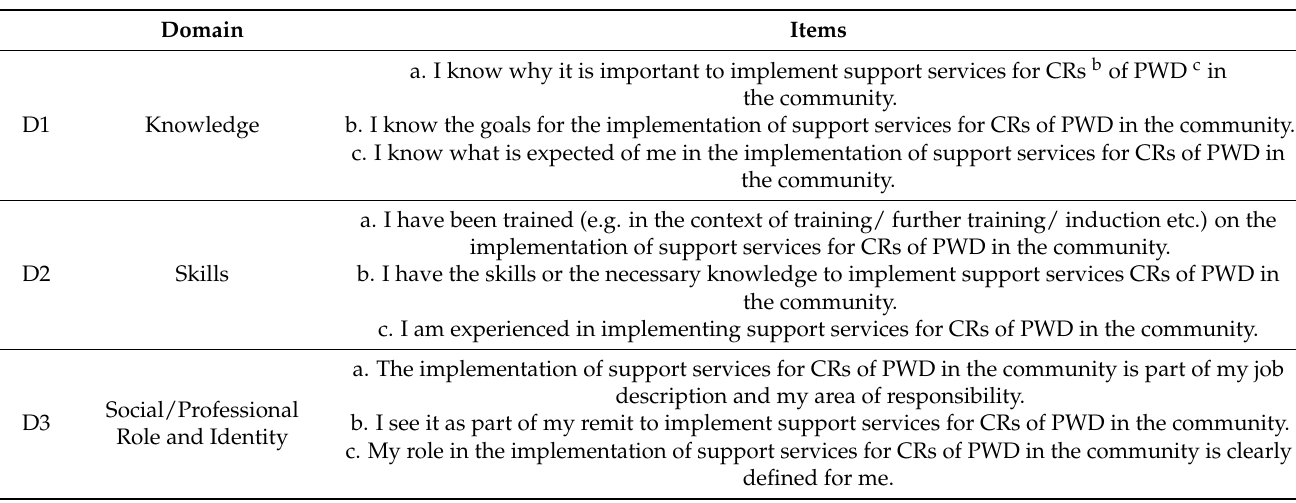
Table A1. Community Implementation Behaviour Questionnaire a